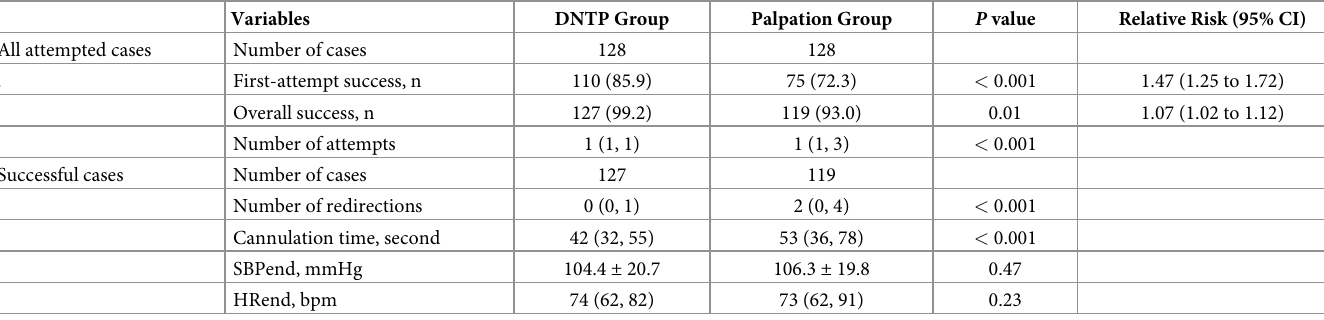
Table 2. Comparison of outcome data of all attempted cases and successful